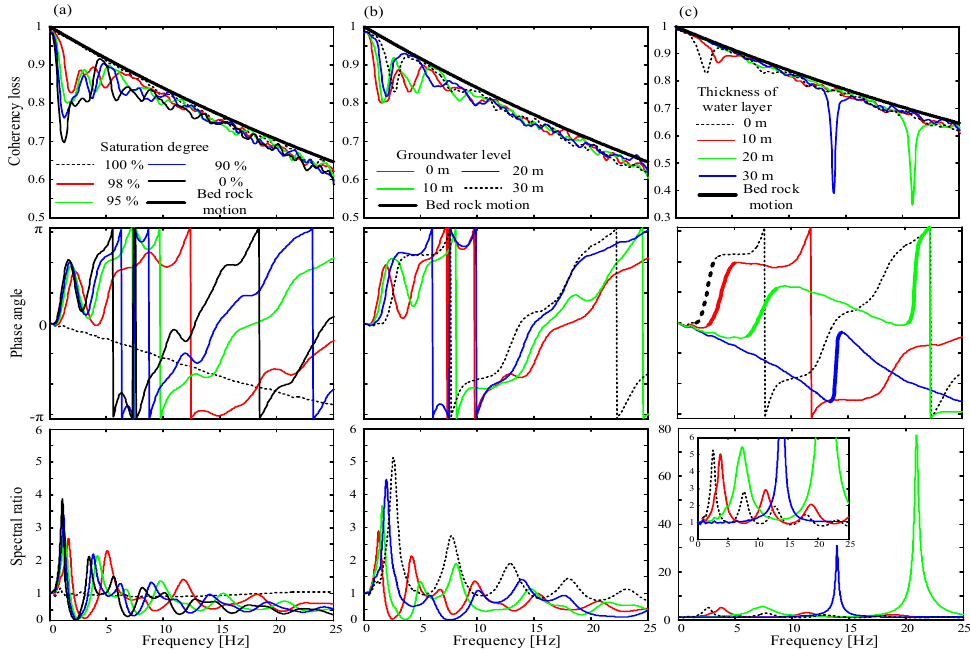
Figure 2. Amplitude of transfer function for varying: ( a ) SD; ( b ) GWL; ( c ) WLT.